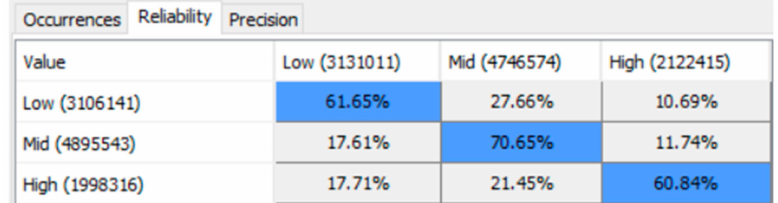
Figure 23. Occurrences confusion matrix after performing target evaluation cross-validation by bootstrapping the data in each node 100,000 times.